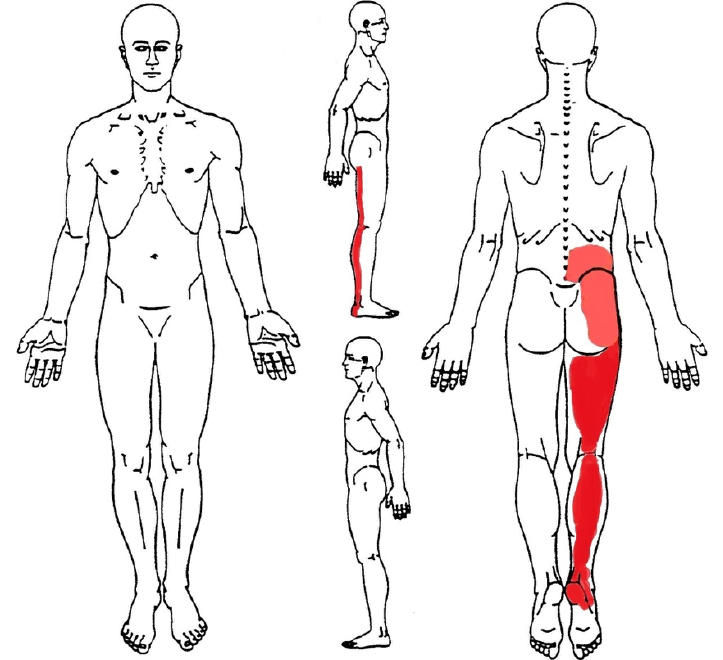
Figure 1. Body chart: Bright red indicates the most painful body areas; pale red indicates the mild painful body areas.